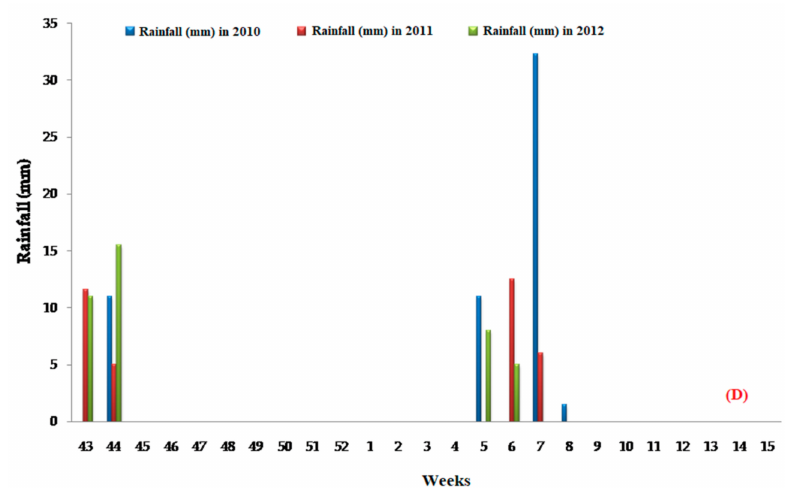
Figure 1. ( A – D ). Weekly weather parameters for consecutive three years for rabi crop cultivation in an arid region (Rajasthan state) of India: ( A ): average temperature, X -axis represents metrological weeks, Y -axis represents the mean temperature in degree centigrade; ( B ): average relative humid- ity, X -axis represents metrological weeks, Y -axis represents mean relative humidity in percentage; ( C ): evaporation, X -axis represents metrological weeks, Y -axis represents mean evaporation in per- centage; ( D ): annual rainfall, X -axis represents metrological weeks, Y -axis represents mean annual rainfall in millimeters.